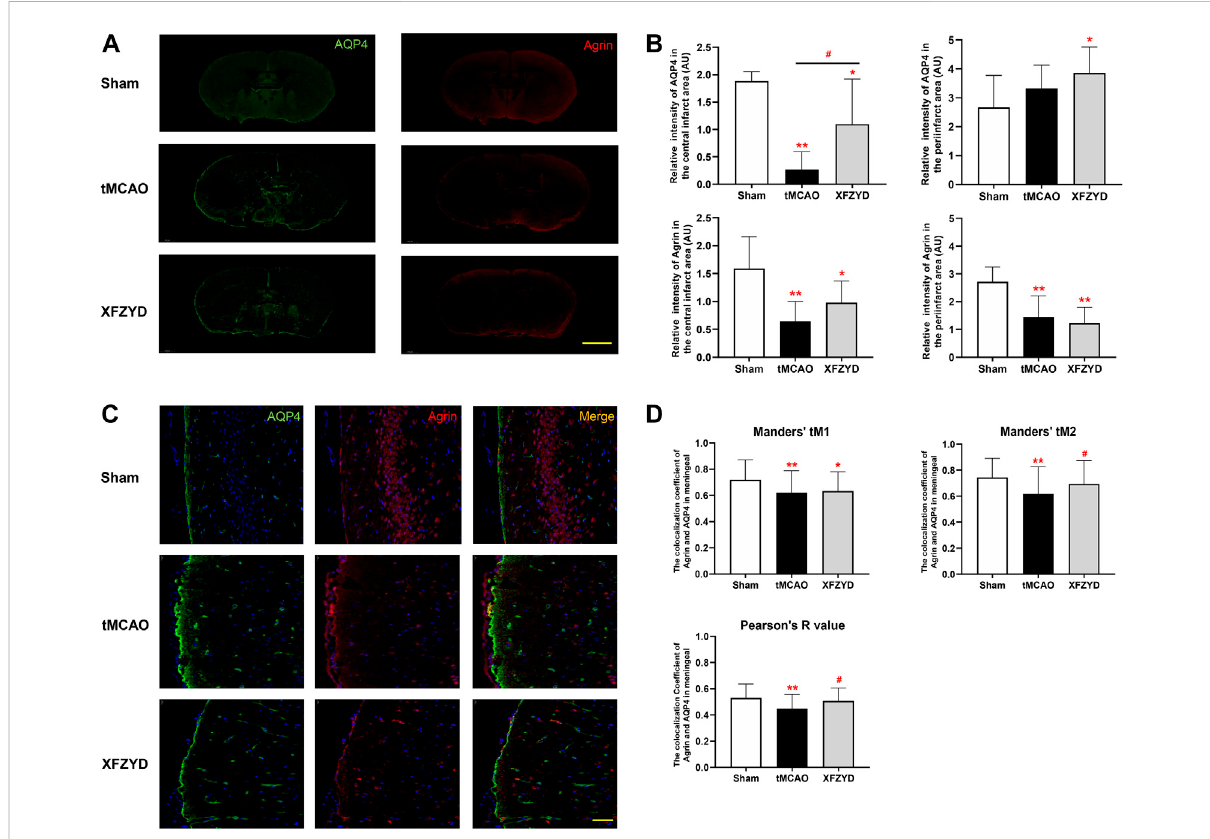
FIGURE 6 Effect of tMCAO and XFZYD on thecolocalization of AQP4 and agrin. (A) The immunostaining of AQP4 and agrin inthe three groups (Scale bar, 1 mm). (B) Quantitative analysis of data A in the infarct and periinfarct areas. (C) Representative colocalization images of agrin and AQP4 immunostaining in the meningeal (Scale bar, 20 μ m) (D) Quanti fi cation of the colocalization of AQP4 and agrin by Manders ’ tM1, Manders ’ tM2andPearson ’ sRvaluefromdifferentgroupsinthemeningeal(* p < 0.05,** p < 0.01vs.theshamgroup, # p < 0.05vs.thetMCAOgroup;Data represent mean ± SD, n =